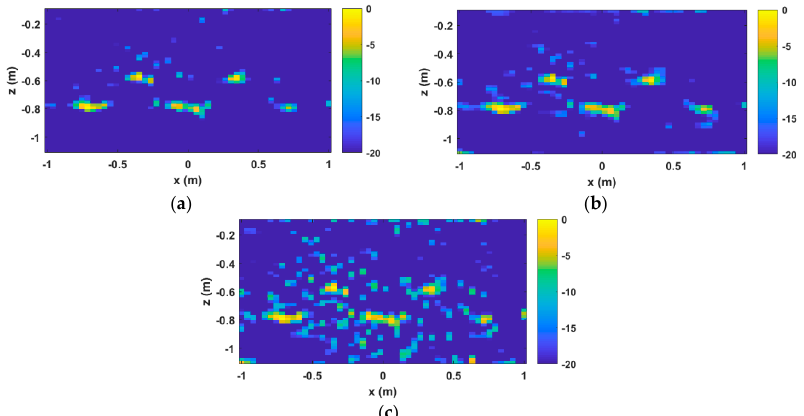
Figure 8. Reconstruction results for composite target scene using two transmitters and six receivers at an SNR of − 5 dB. ( a ) GSR; ( b ) TVM; ( c ) standard l 1 -norm minimization.